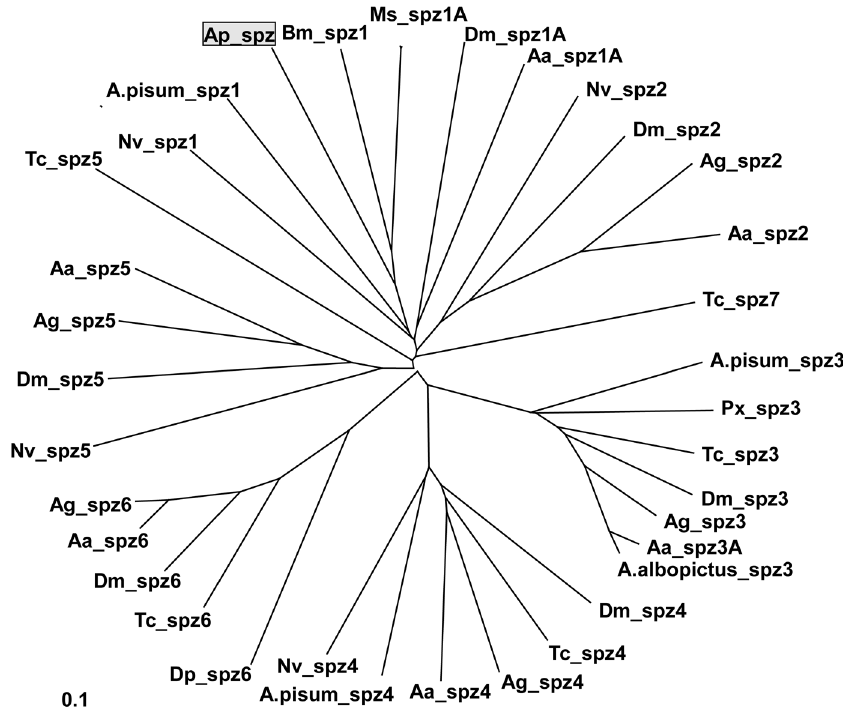
Fig 3. Phylogenetic analysis of the spatzles from A . pernyi and other insect species. The abbreviations and the GenBank accession numbers of the spatzles are shown in S2 Table.